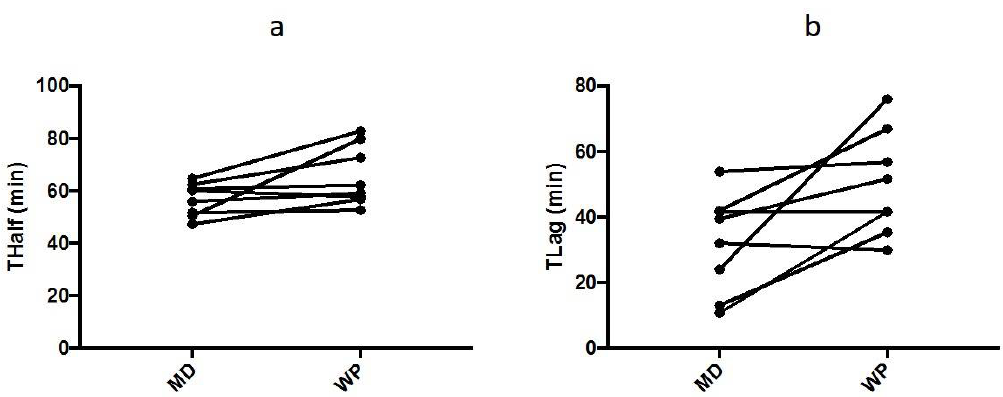
Figure 2. ( a ) Individual data for T 1/2 and ( b ) T lag during the maltodextrin (MD) and whey protein (WP) trials.